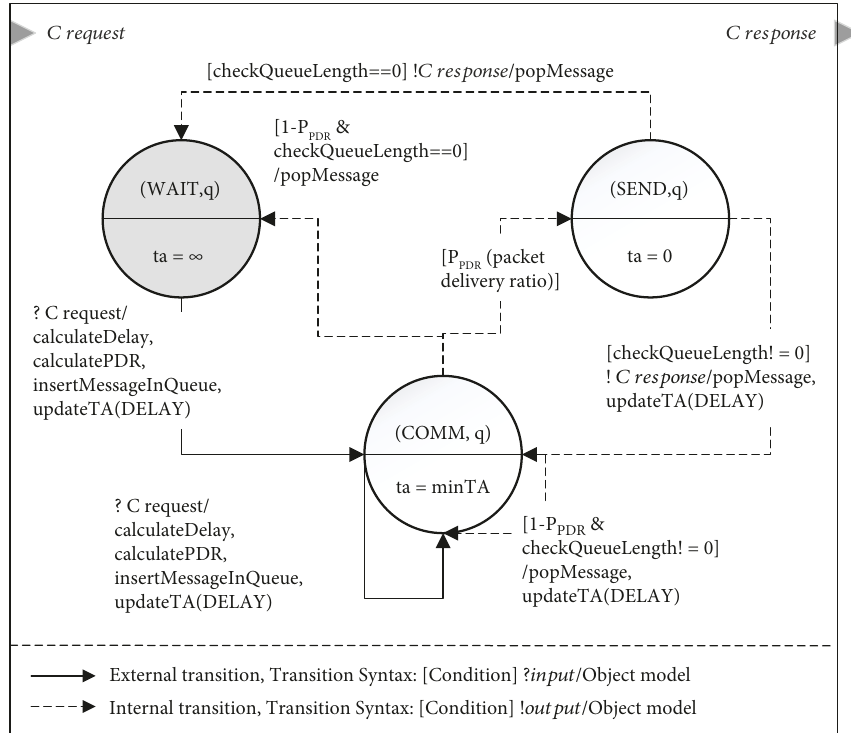
Figure 7: Abstracted network model using the DEVS formalism